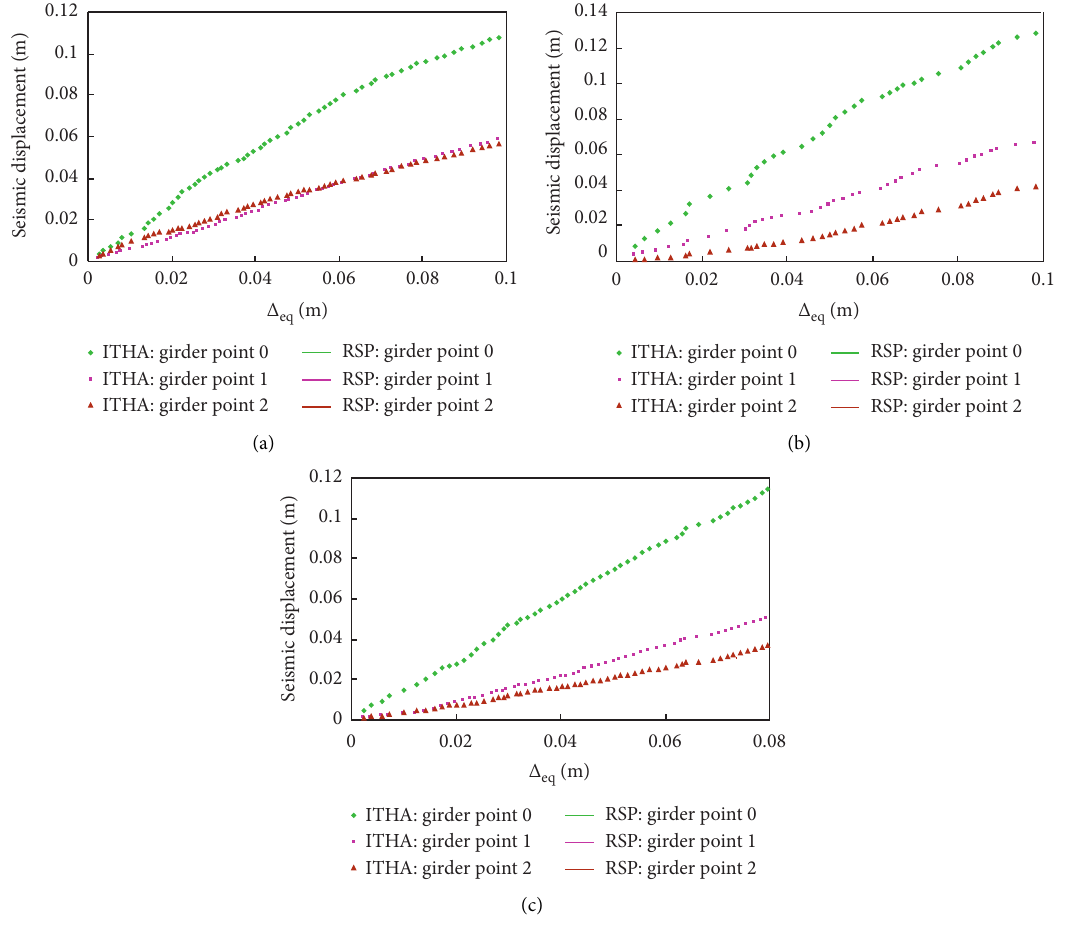
Figure 6: Comparison of seismic displacement by ITHA and RSP: (a) 051005 bridge, (b) 100510 bridge, and (c) 050505 bridge.